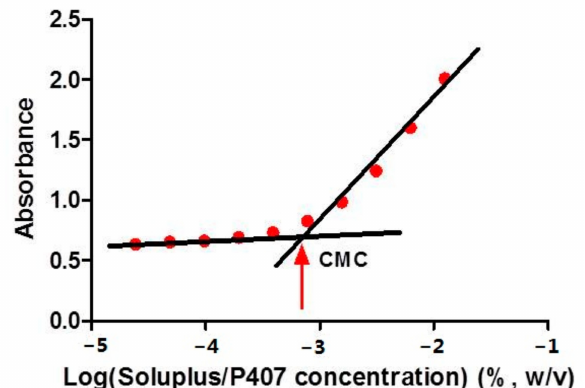
Figure 1. Plot of the absorbance at 366 nm as a function of log(1/ C ) for the mixture of Soluplus ® /P407 in the mass ratio of 2:1 in aqueous solution. CMC, critical micelle concentration; P407, poloxamer